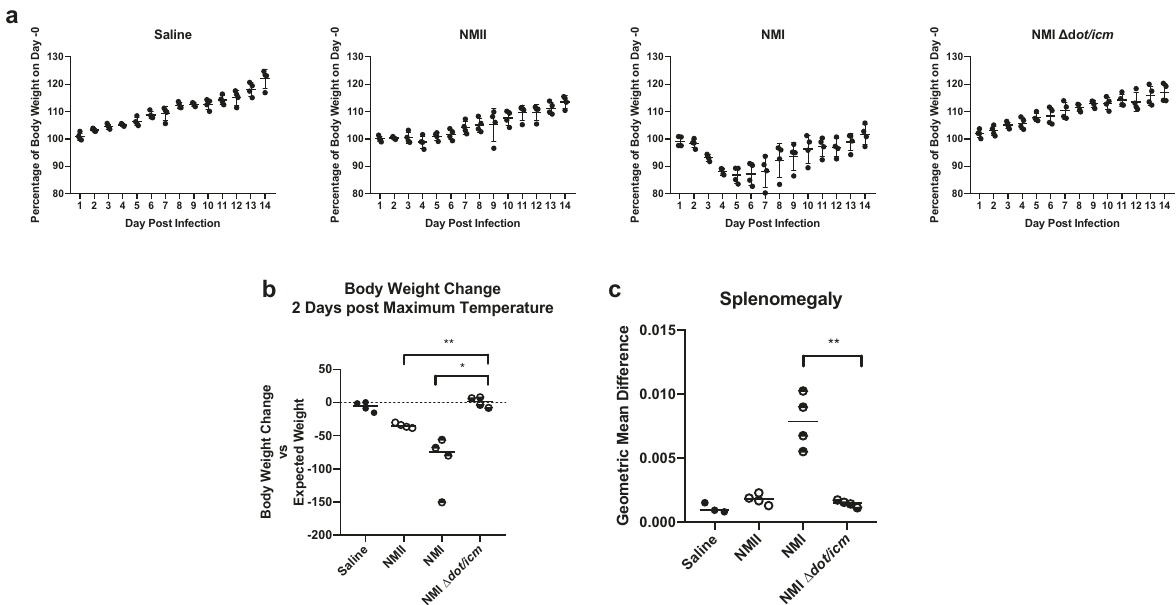
Fig. 4 Infection by NMI Δ dot/icm does not cause body weight loss or splenomegaly in guinea pigs. a Body weight change is presented as percentage of body weight altered at any given day compared to day 0 post-infection. b Body weight change at 2 days post maximum temperature is presented as body weight change vs expected weight at the measured time point for each individual animal, with a dotted line at 0 indicating no change. c At euthanasia (14 days post-infection), splenomegaly was quanti fi ed and data are presented as geometric mean difference of spleen weight normalized to total body weight. Body weight change and splenomegaly were evaluated based on differences in group means (horizontal bar) with associated con fi dence intervals. Error bars represent standard deviation. For each reported comparison, p -values were computed at the α = 0.05 level for two-sided two-sample t tests, allowing for unequal variances between groups. No adjustment was made for multiple comparisons due to the sample sizes ( n = 4) and the descriptive nature of the study. * p ≤ 0.05, ** p ≤